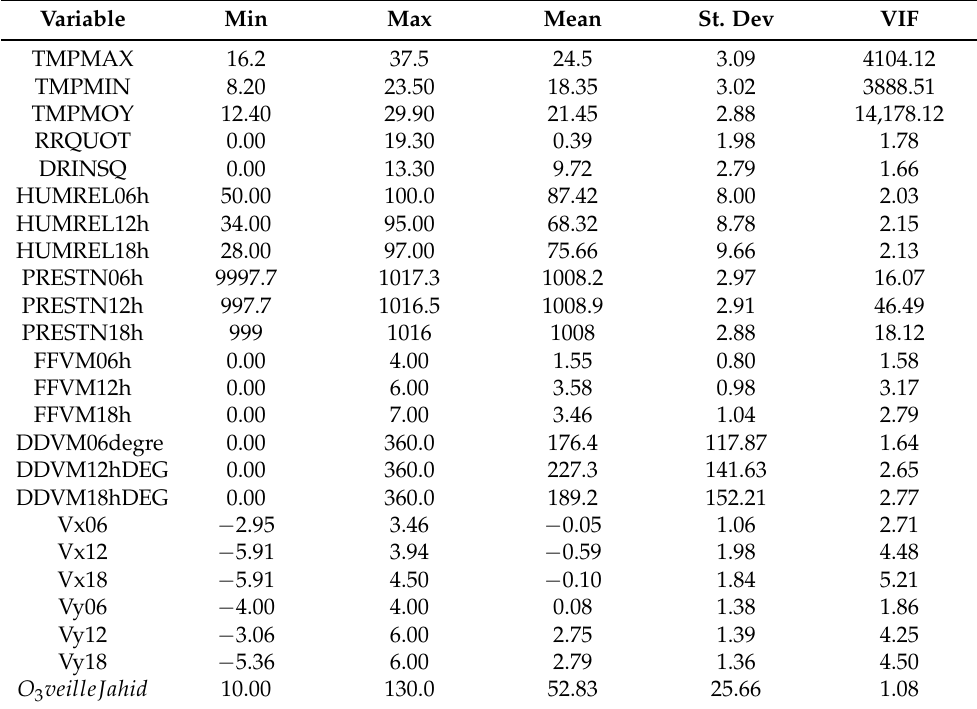
Table 2. Statistics of measured variables at GCR from 01 April to 30 September in 2013 and 2014.